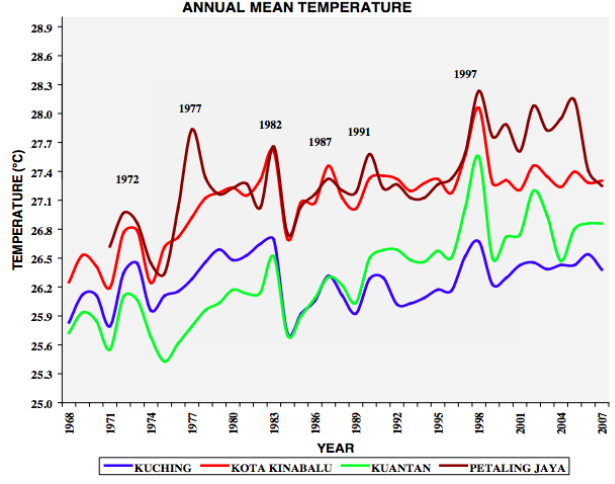
Figure 11. Annual Mean Temperature Trend for 4 Meteorological Stations (Courtesy: Malaysia Meteorological Department).